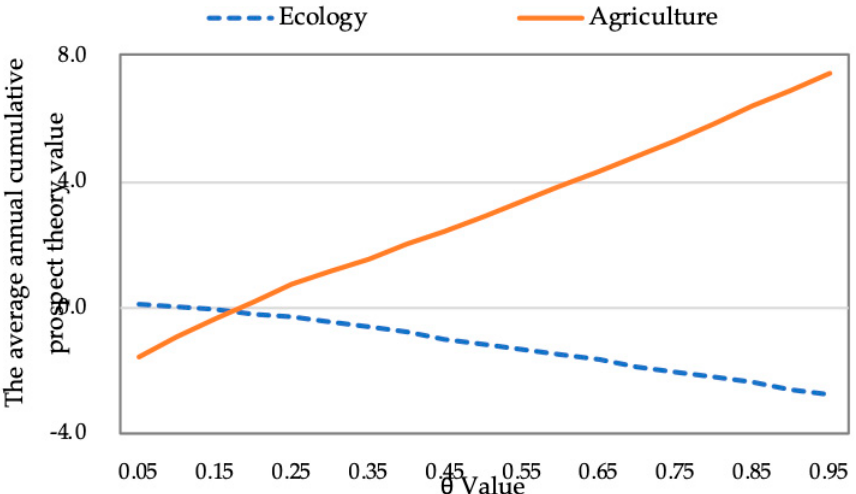
Figure 9. The cumulative prospect theory values for ecological and agricultural water in different preferences of decision-makers.